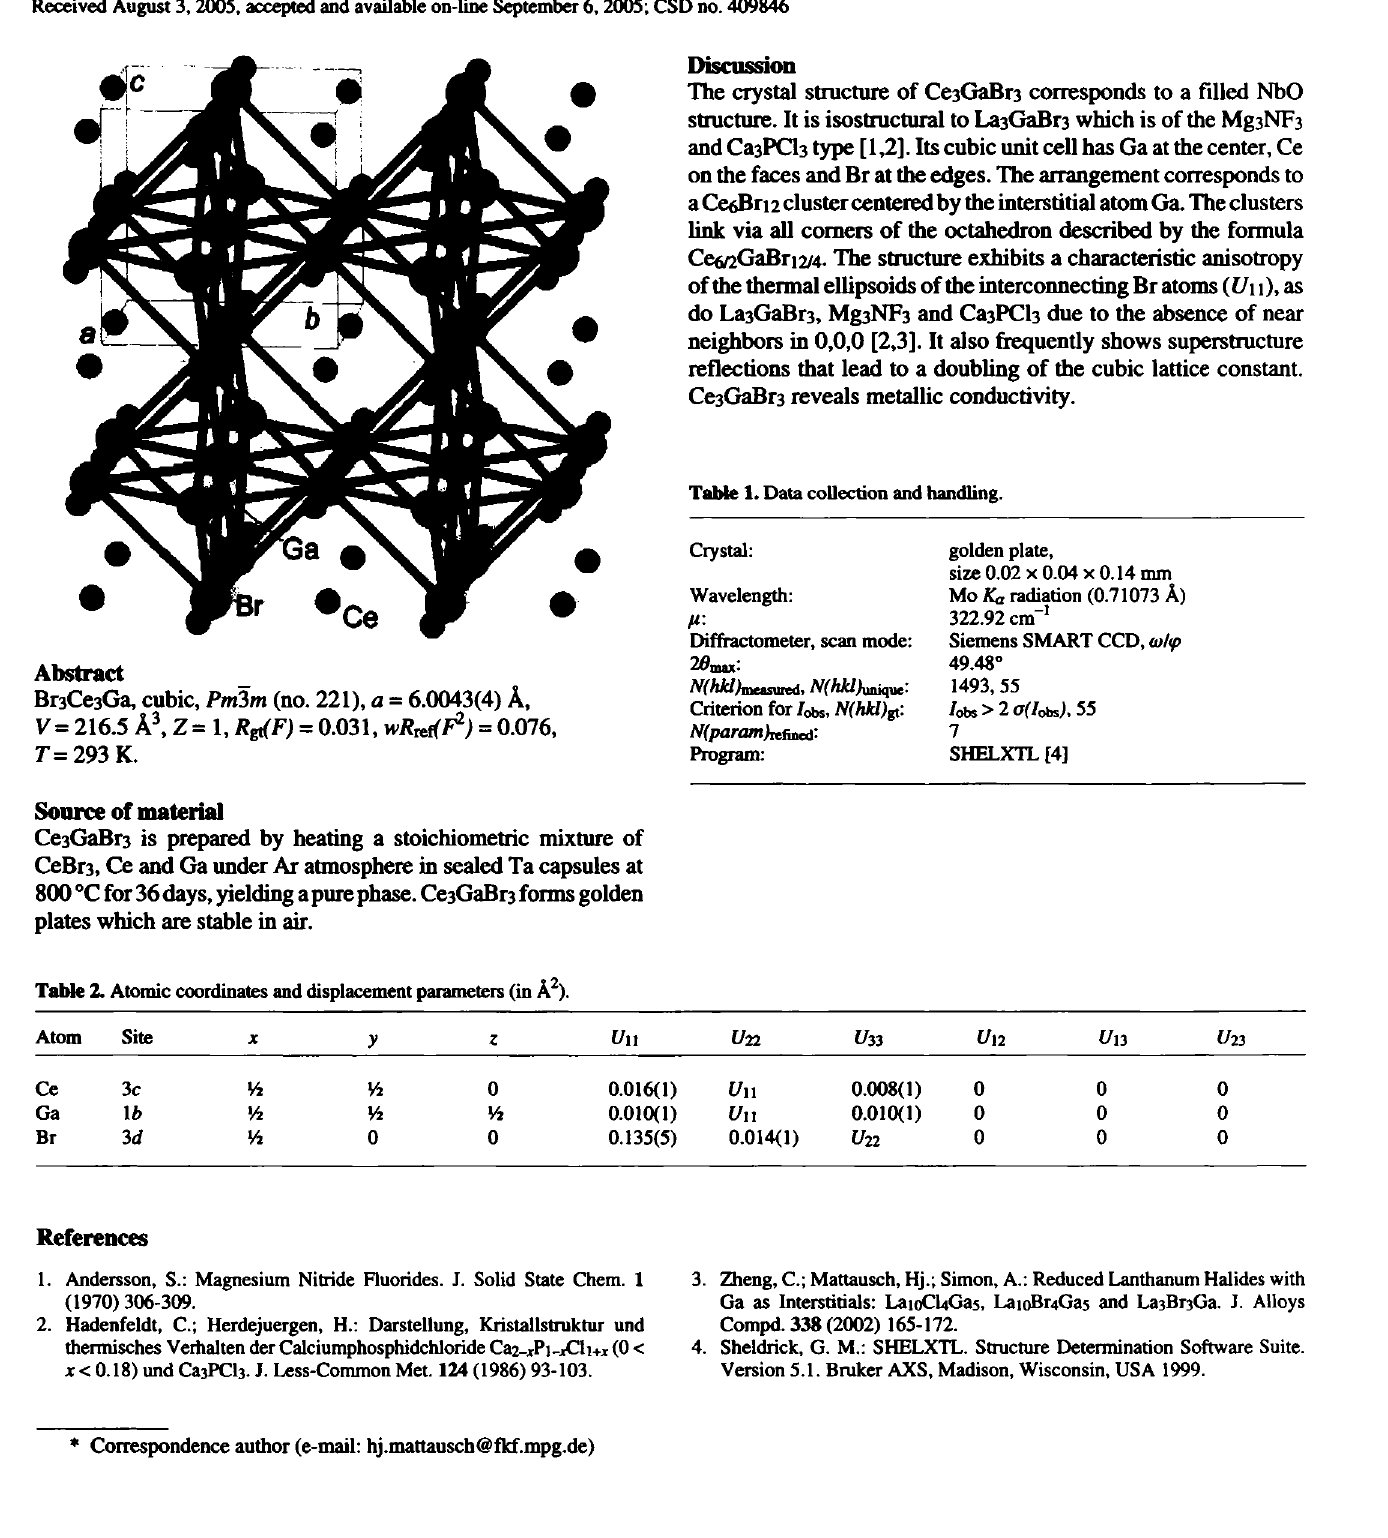
Table 1. Data collection and handling.